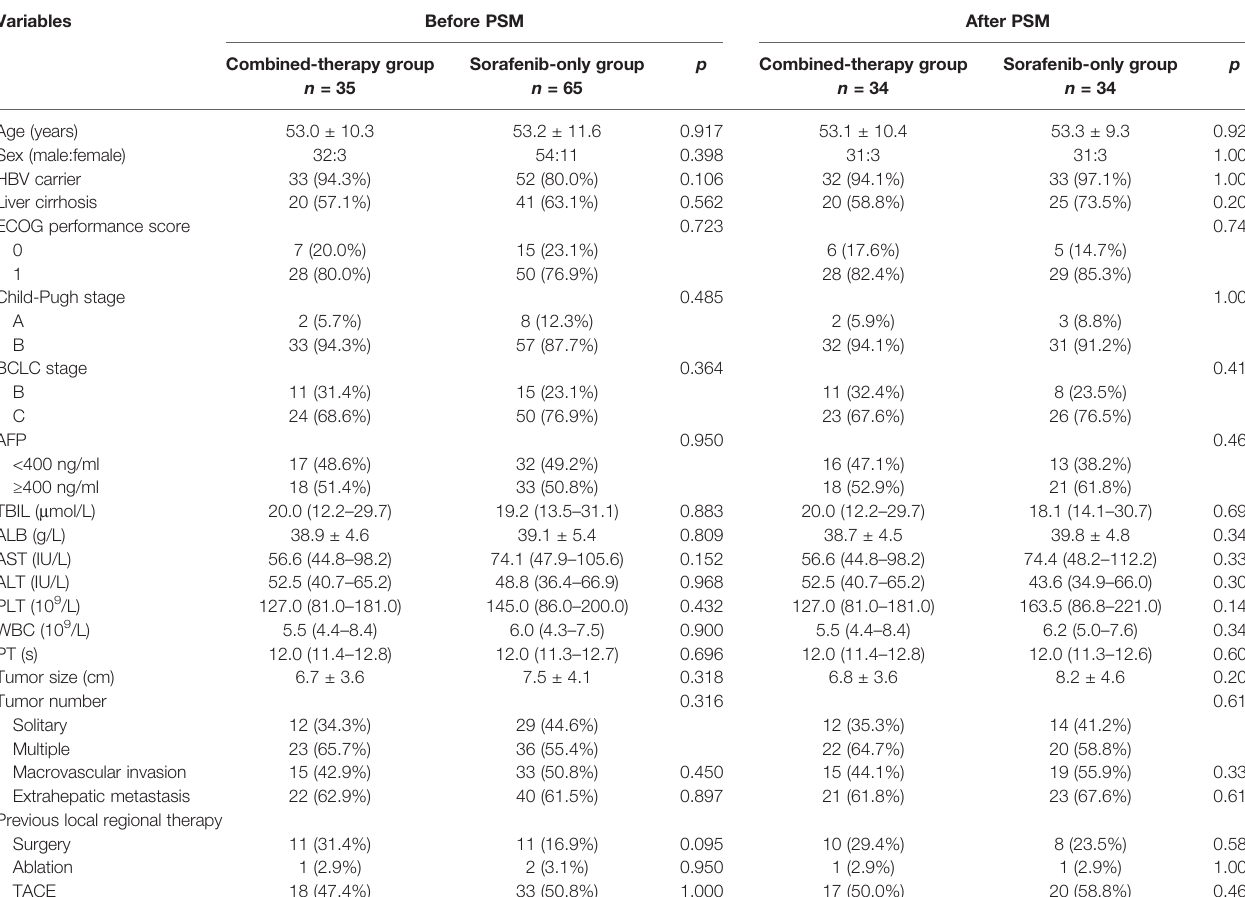
TABLE 1 | The baseline patient characteristics. Variables Before PSM After PSM Combined-therapy